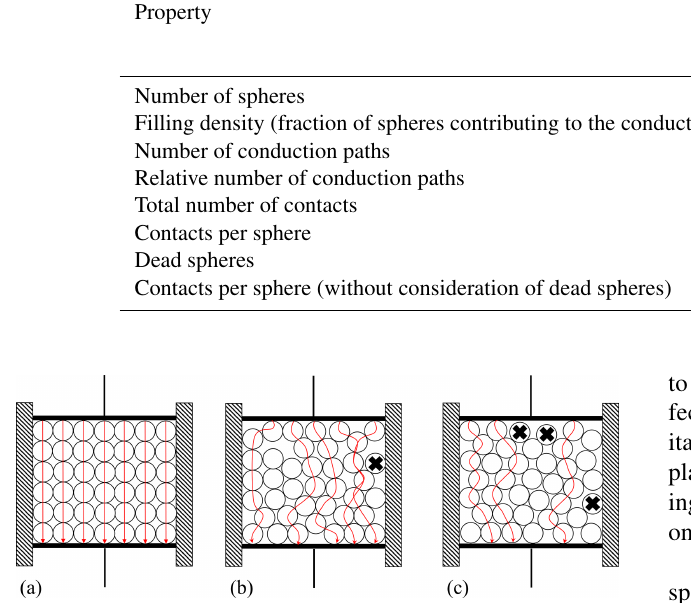
Figure 8. Schematic model of the two-component system of sand (spheres) and air. The arrows represent the direct, i.e., shortest, con- duction paths for the electric current. The particles marked with x are so-called dead grains of sand since they do not contribute to the conduction